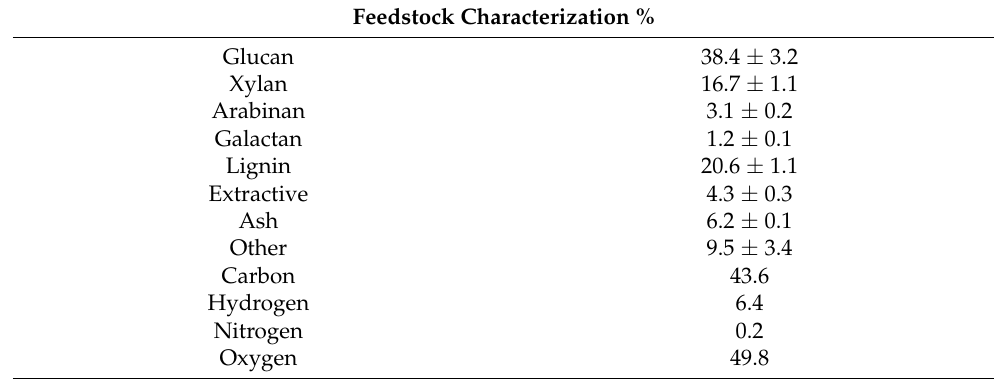
Table 1. Composition of raw wheat